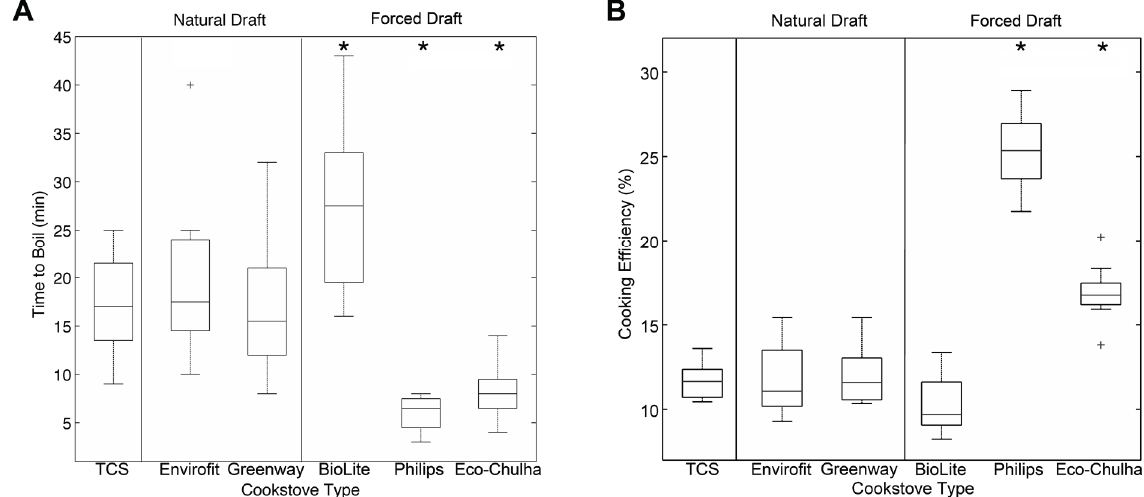
Figure 4. ( A ) Boxplots depicting time to boil 2 L of water, in minutes. The BioLite stove required significantly more time than the TCS ( p = 0.001); the Greenway and Phillips ( p < 0.01) required significantly less time to boil water than the TCS. ( B ) Cooking efficiency